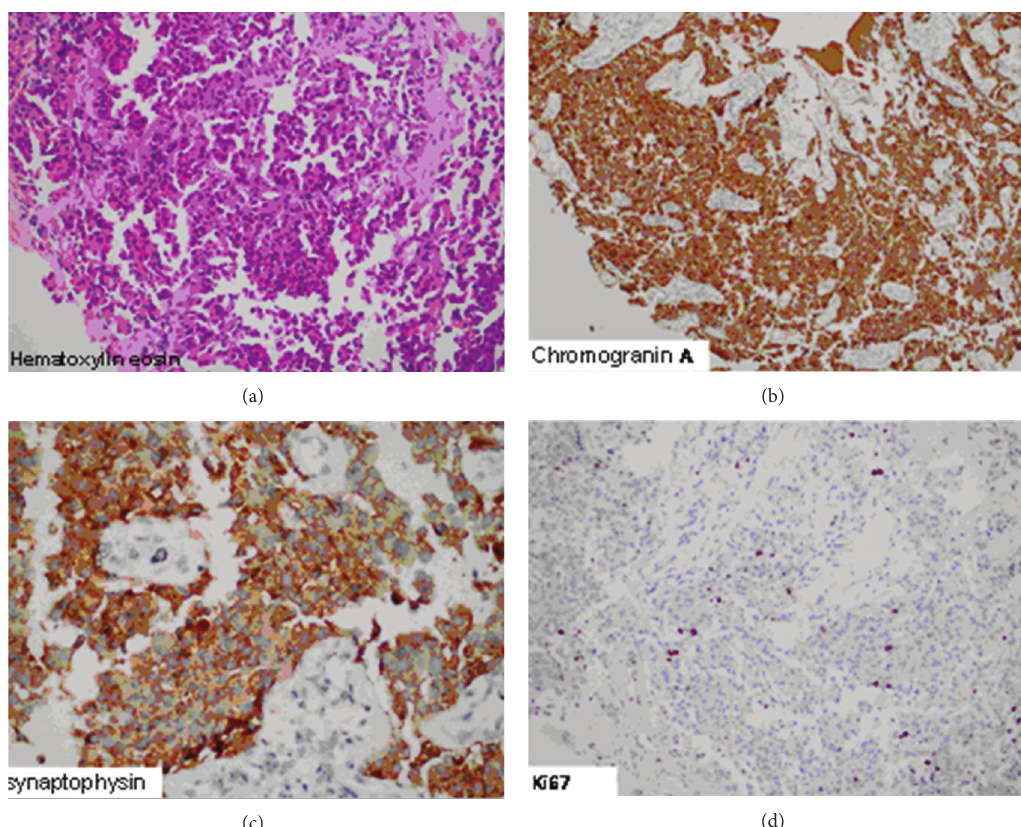
Figure 2: Pathologic specimens of liver metastases, Hematoxylin eosin, chromogranin A and Ki 67 with × 100 magnification, Synaptophysin with × 200